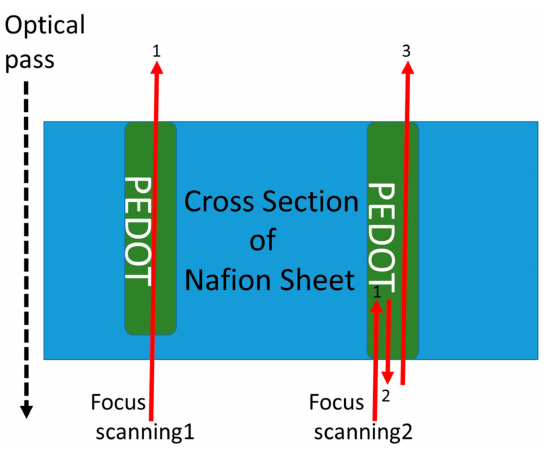
Figure 6. Schematic diagram at the cross section of the Nafion sheet to explain the di ff erence in the procedure of the laser focus scanning in the sheet. Focus scanning 1 and 2 correspond to the previous conductivity evaluation method and the new method,